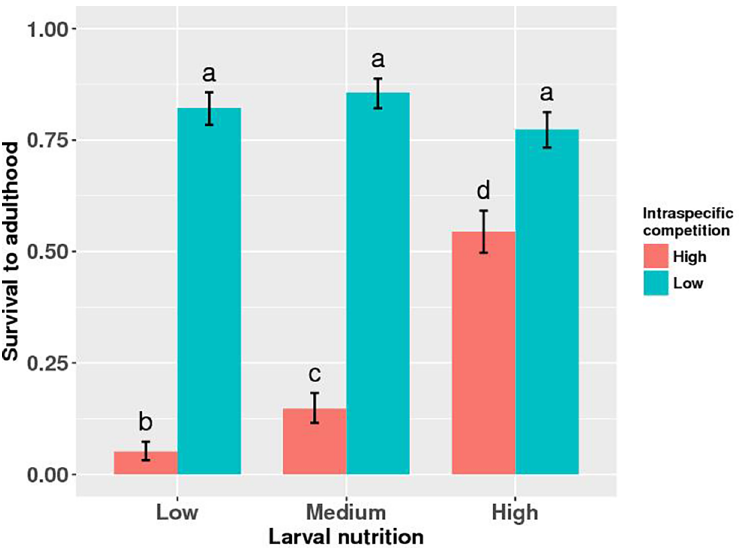
Fig 1. Survival to adulthood. Proportion survivorship to eclosion of Aedes aegypti larvae exposed to intraspecific competition and nutrition treatments. Values plotted are least squares means ± SE pooled across three predation treatments. Data were statistically tested using ANOVA and significant effects are described in Table 1. Treatment means associated with the same letters are not significantly different. (Table 2). Multivariate pairwise contrasts revealed significant differences for nine of the pair- wise comparisons for effects of nutrition and competition (Table 2). Standardized canonical